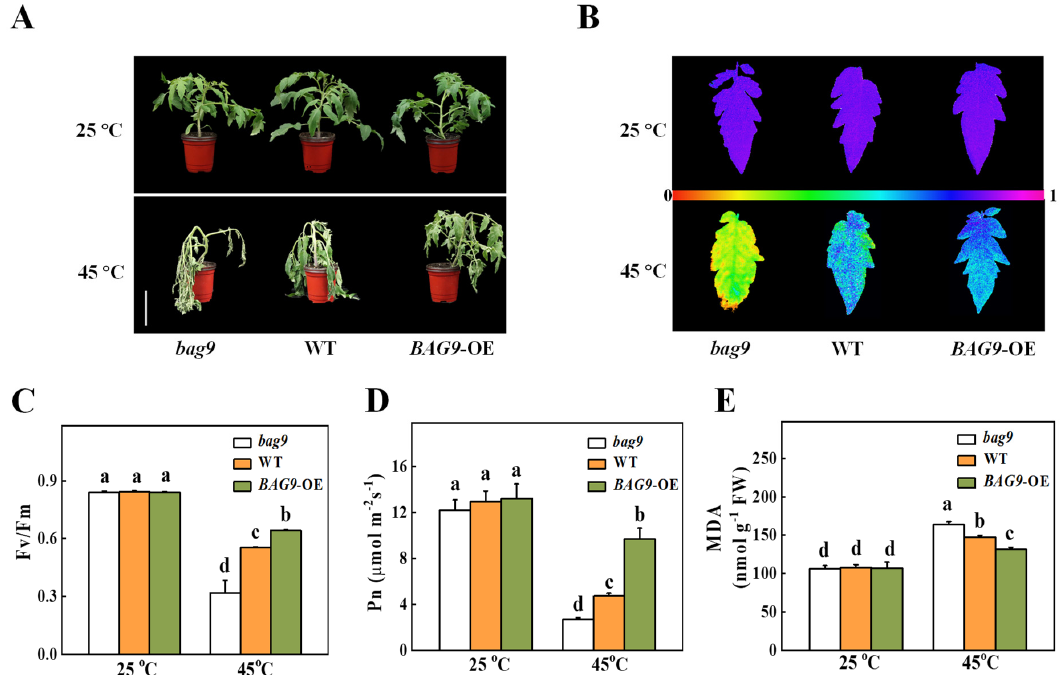
Figure 3. Influence of BAG9 on tomato thermotolerance. ( A ) Representative images of bag9 mutants, wild type (WT), and BAG9 overexpressing ( BAG9 -OE) plants without or with heat stress. Bar = 10 cm. The plants were subjected to normal temperature (25 °C) or high temperature (45 °C) treatment for 10 h, photographs of plants were then taken. ( B , C ) After undergoing different temperature treatments for 7 h, images of representative leaves showed the maximum photochemical efficiency of photosystem II ( Fv/Fm ). At the bottom, a color gradient showed the strength of the fluorescence signal depicted by each color. ( D ) Net photosynthetic ( P n) efficiency at 7 h under heat. ( E ) MDA content at 7 h under heat or without heat stress. Data were the means ± SD of three biological replicates. Different letters represented significant differences ( p < 0.05) according to Tukey’s test.